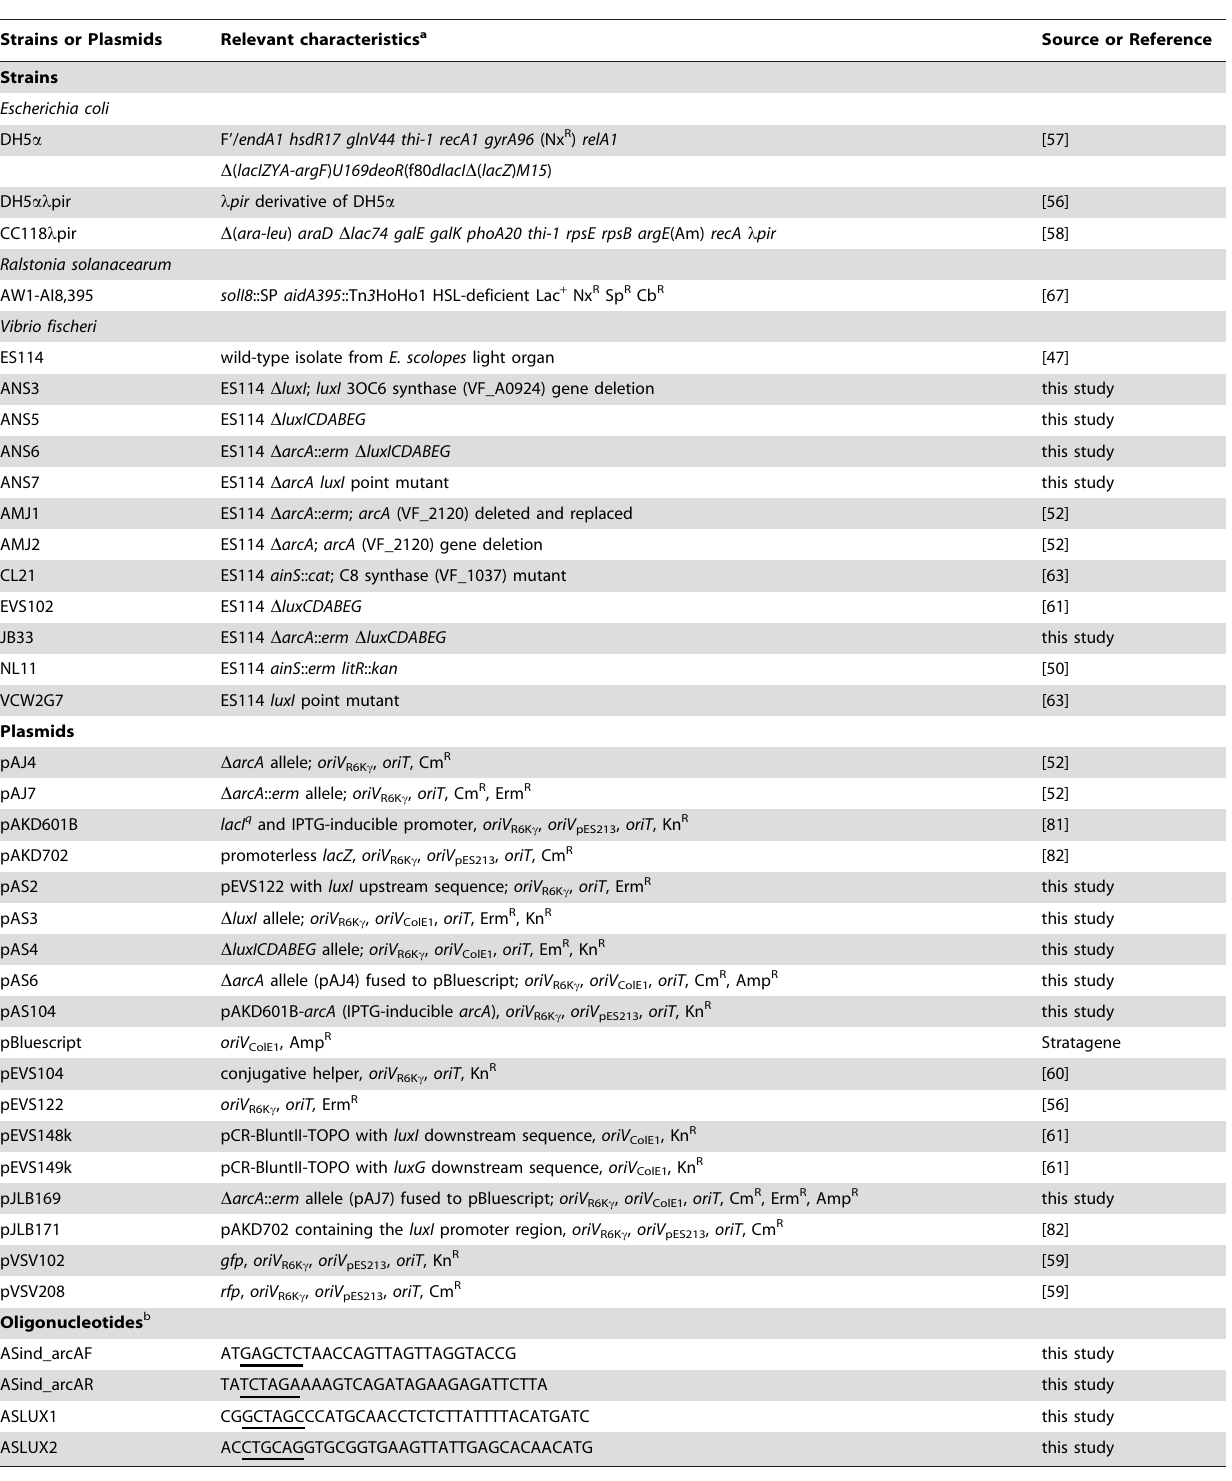
a Kn R , Kanamycin resistance; Cm R and cat, Chloramphenicol resistance; Erm R and erm, Erythromycin resistance; Amp R , Ampicillin resistance; Nx R , Nalidixic acid resistance; Sp R , Spectinomycin resistance; Cb R , Carbenicillin resistance. Plasmid replication origins are designated oriV with a subscript indicating the source, and oriT indicates the RP4 origin of transfer. b Oligonucleotides are in the 5 9 to 3 9 orientation with introduced restriction sites underlined.